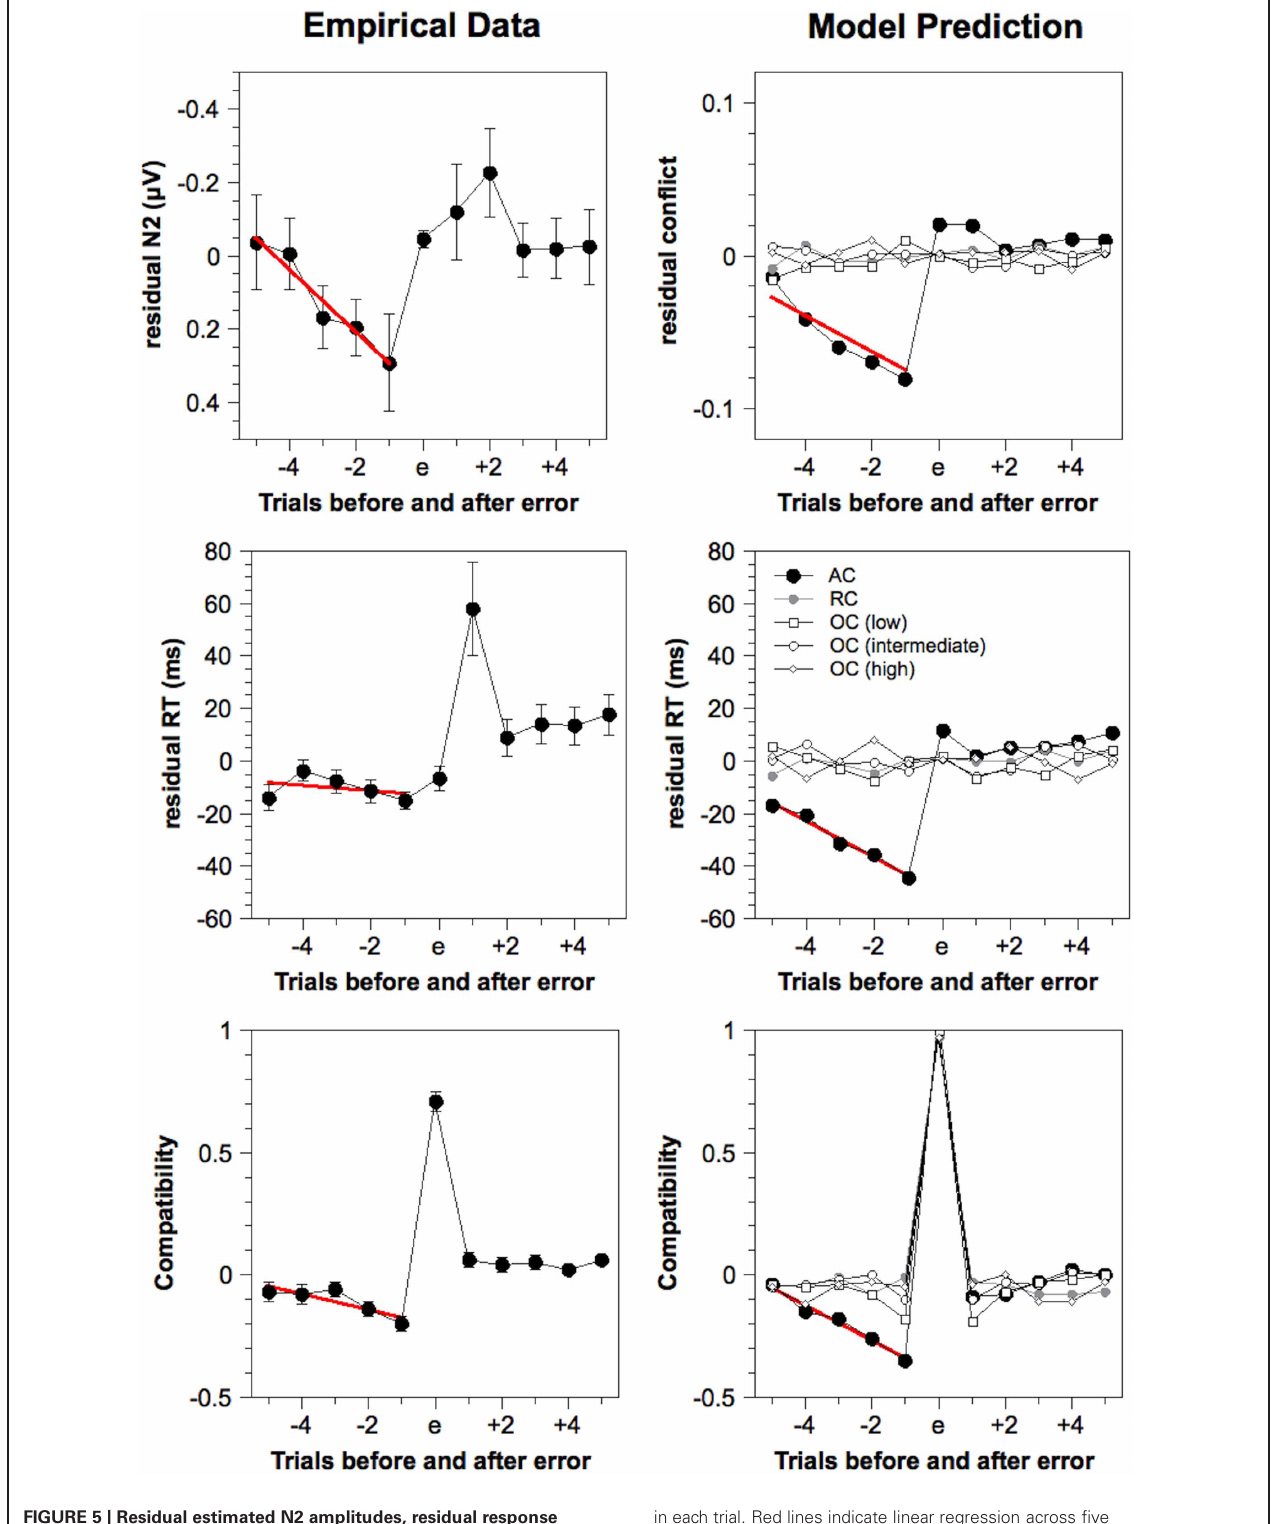
FIGURE 5 | Residual estimated N2 amplitudes, residual response times, and compatibility around errors for the empirical and model data, as obtained by de-convolution analysis. Simulated N2 amplitude is estimated by the cumulated pre-response conflict